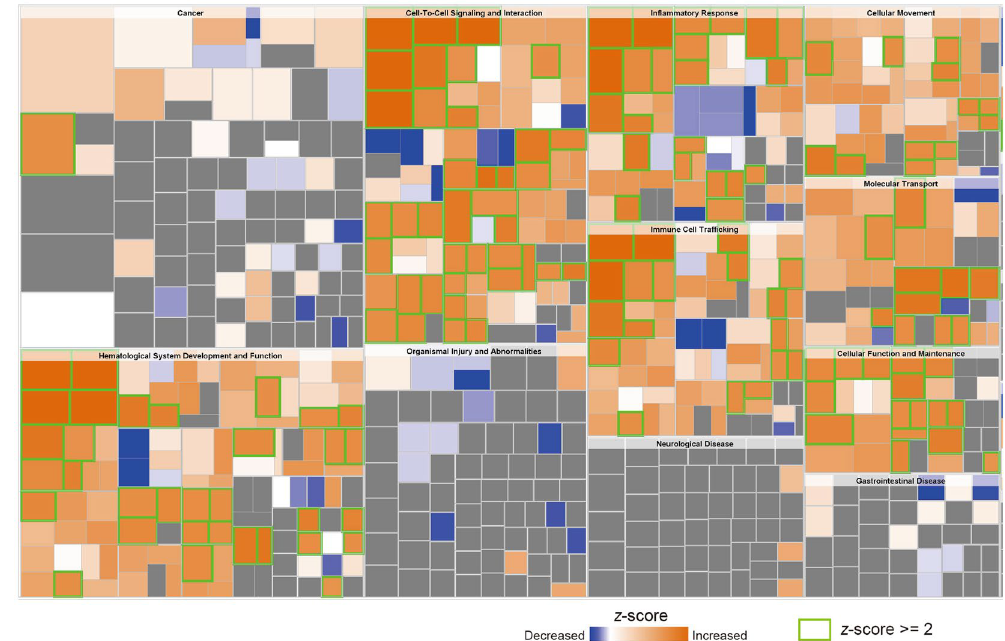
Figure 3. Prediction of functions in HUVECs treated with exosomes released from PK-45H cells. The effects on the functions in treated HUVECs were examined by analysis of the ‘disease and functions’ of the IPA system. Size and colour are shown by the − log ( P -value) or z -score, respectively. Orange and blue colours in the heat map indicate higher and lower z -scores, respectively. Green scale represents ‘Increased ( z -score > 2.000)’ functions. The category data for 75 ‘increased ( z -score > 2.000)’ and 1 ‘decreased ( z -score < − 2.000)’ are shown in Supplementary Table S3. The category of ‘cell-to-cell signalling and interaction’ included a number of ‘increased ( z -score >